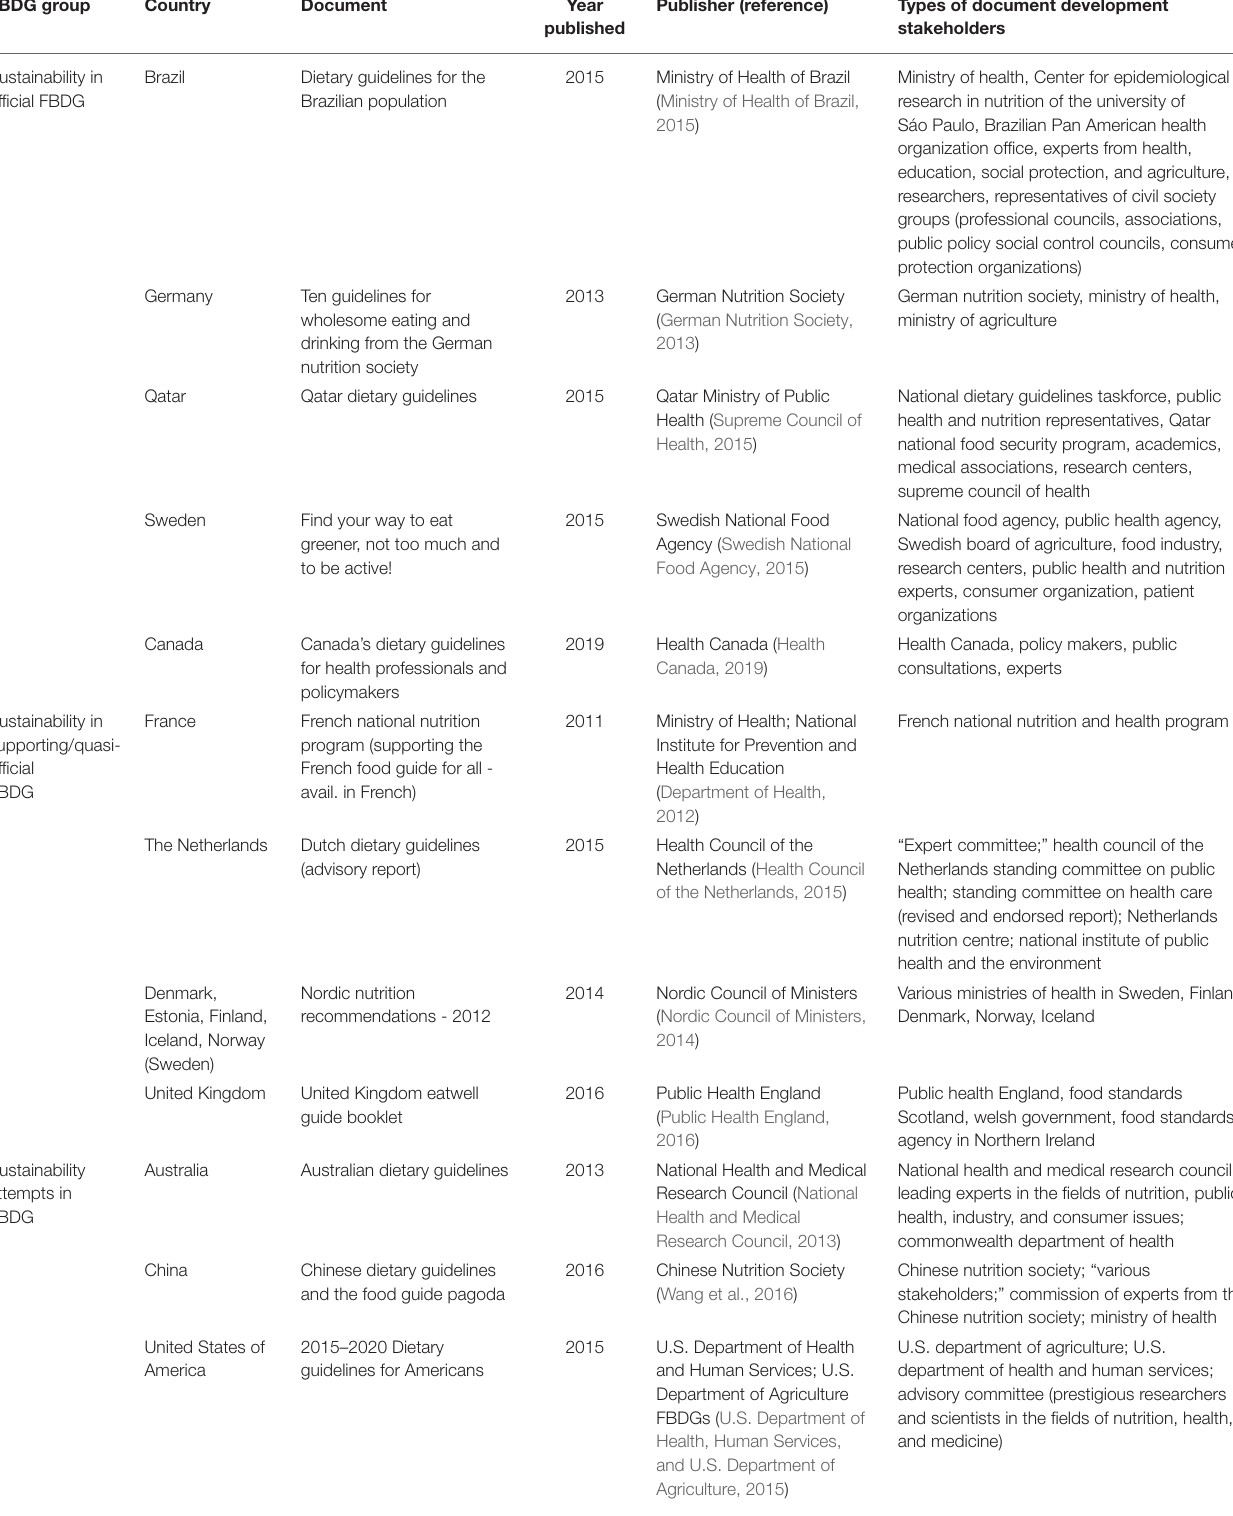
TABLE 1 | Summary of Food-based Dietary Guidelines and related documents examined ( n = 12), table separated by category of sustainability inclusion. FBDG